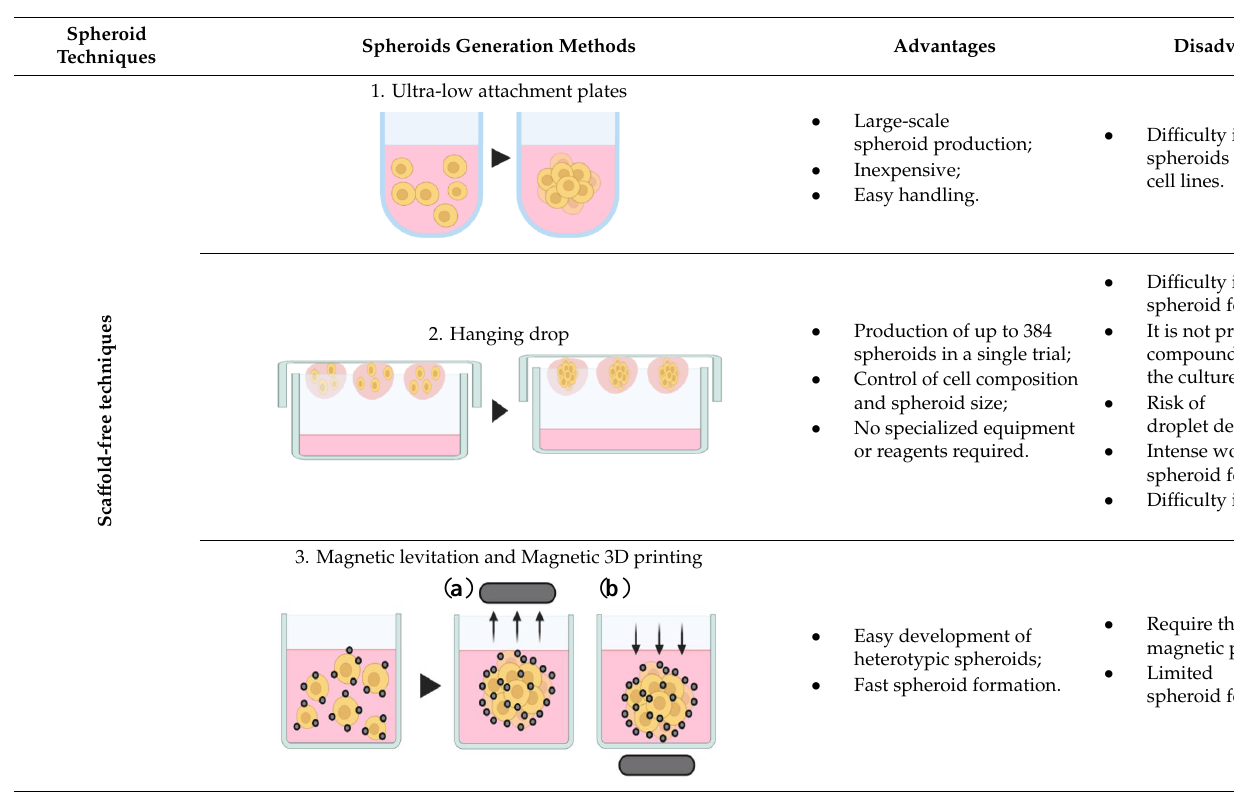
Table 3. Advantages and disadvantages of the main methods used for spheroid generation.